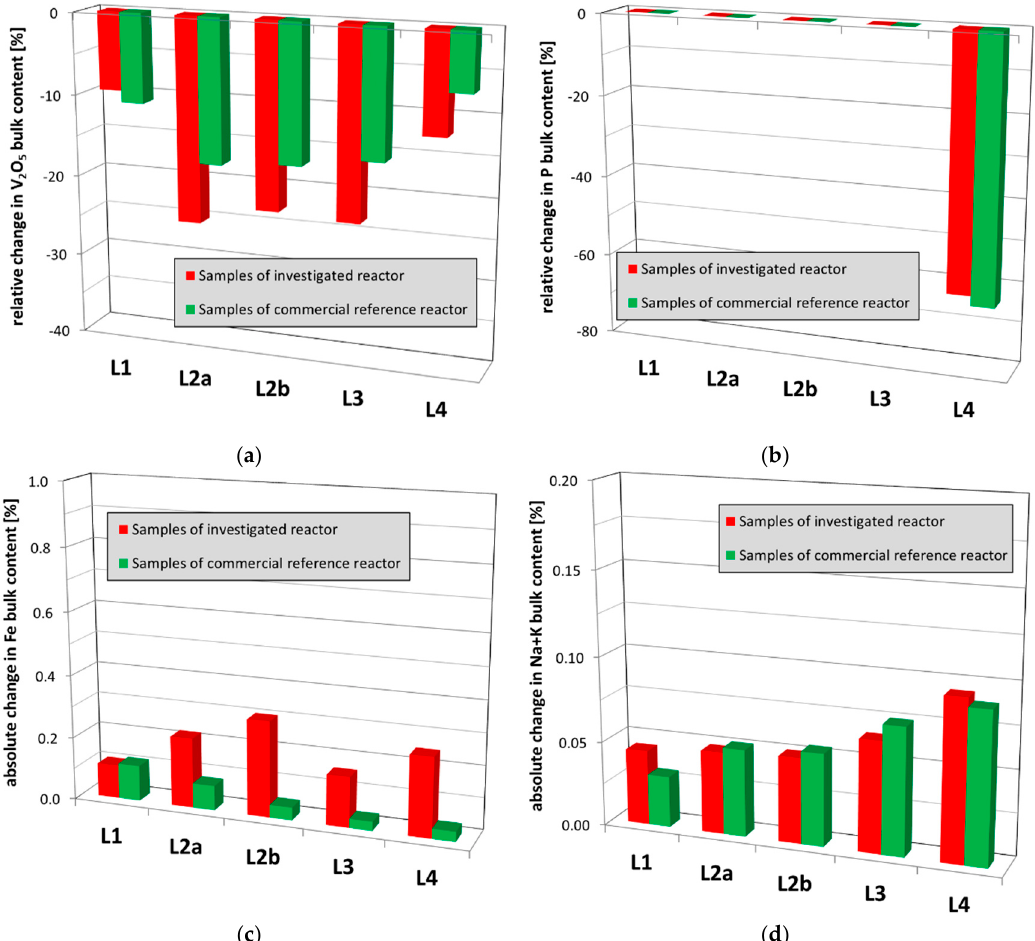
Figure 9. Comparison of the chemical bulk composition of used catalyst samples from the investigated reactor and the commercial reference reactor: ( a ) relative change in vanadium bulk content (calculated as V 2 O 5 ); ( b ) relative change in phosphorous (P) bulk content; ( c ) absolute changes in iron (Fe) bulk content; ( d ) absolute changes in sodium and potassium (Na + K) bulk content. The samples of each layer were averaged.